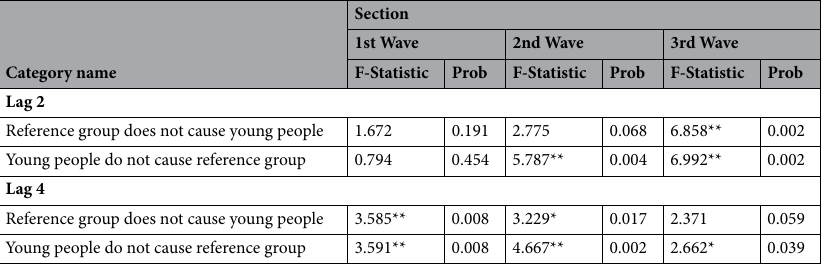
Table 4. Pairwise Granger causality tests results between groups by section. Here *p < 0.05; **p < 0.01.